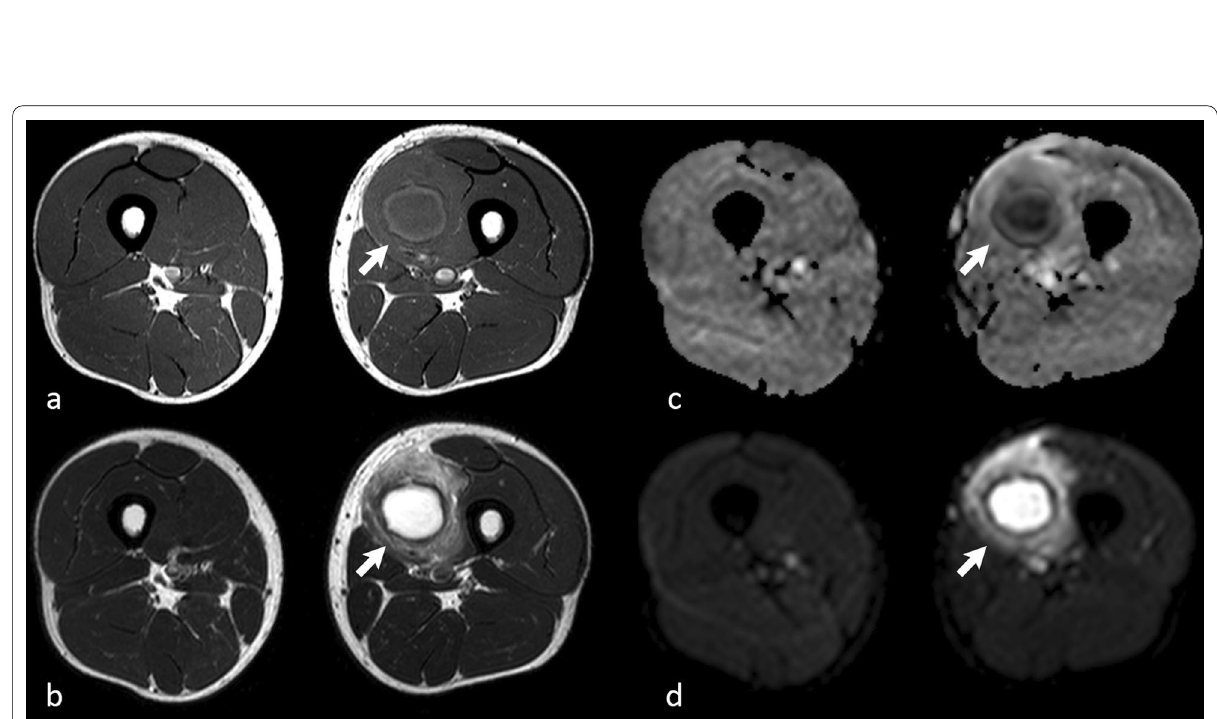
Fig. 4 27-year-old male patient complaining of swelling and worsening pain in the left thigh for a week. Axial turbo spin echo (TSE) nonenhanced T1-w. image a shows a cystic round lesion (arrow) within the vastus medialis muscle of the left thigh. TSE T2-w. scan ( b ) at the same level well depicts the edema of the muscle around the lesion. A clear, subtle rim (hyperintense in a and strongly hypointense in b ) encircling the cystic component can be noted, representing the lesion wall. The mass shows typical central restricted diffusion on the apparent diffusion coefficient map ( c ) and on the diffusion-weighted imaging ( d ) sequence. The findings were consistent with muscular abscess